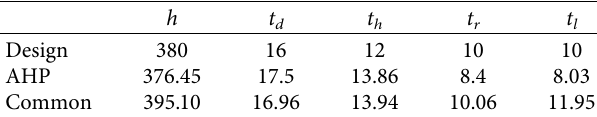
Table 7: Optimization results of parameter calculation (unit: